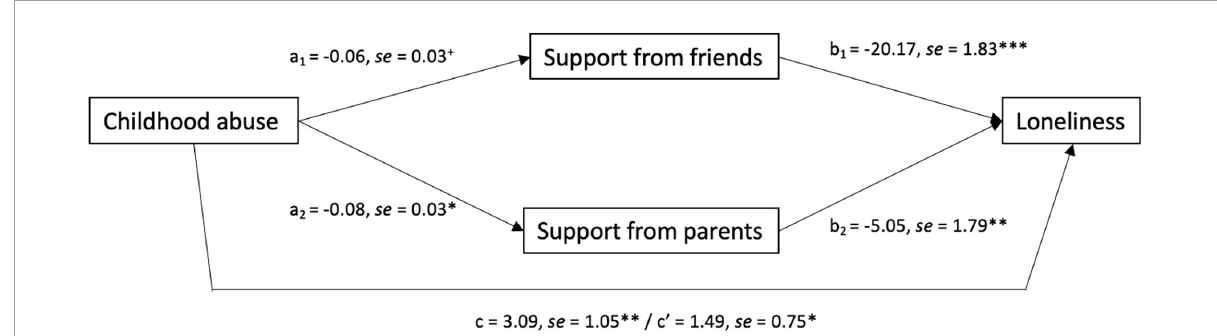
FIGURE1 Mediated relationship between experiences of childhood abuse and loneliness through perceived social support from friends and parents in Study 1. Path coefficients indicate that childhood abuse was associated with perceived support and such perceptions were, in turn, related to loneliness. Perceived support partially accounted for the relationship between experiences of child abuse and loneliness among young adults. c represents the total effect, whereas c’ represents the direct effect. + p < 0.10; ∗ p < 0.05; ∗∗ p < 0.01; ∗∗∗ p < 0.001. N = 171.